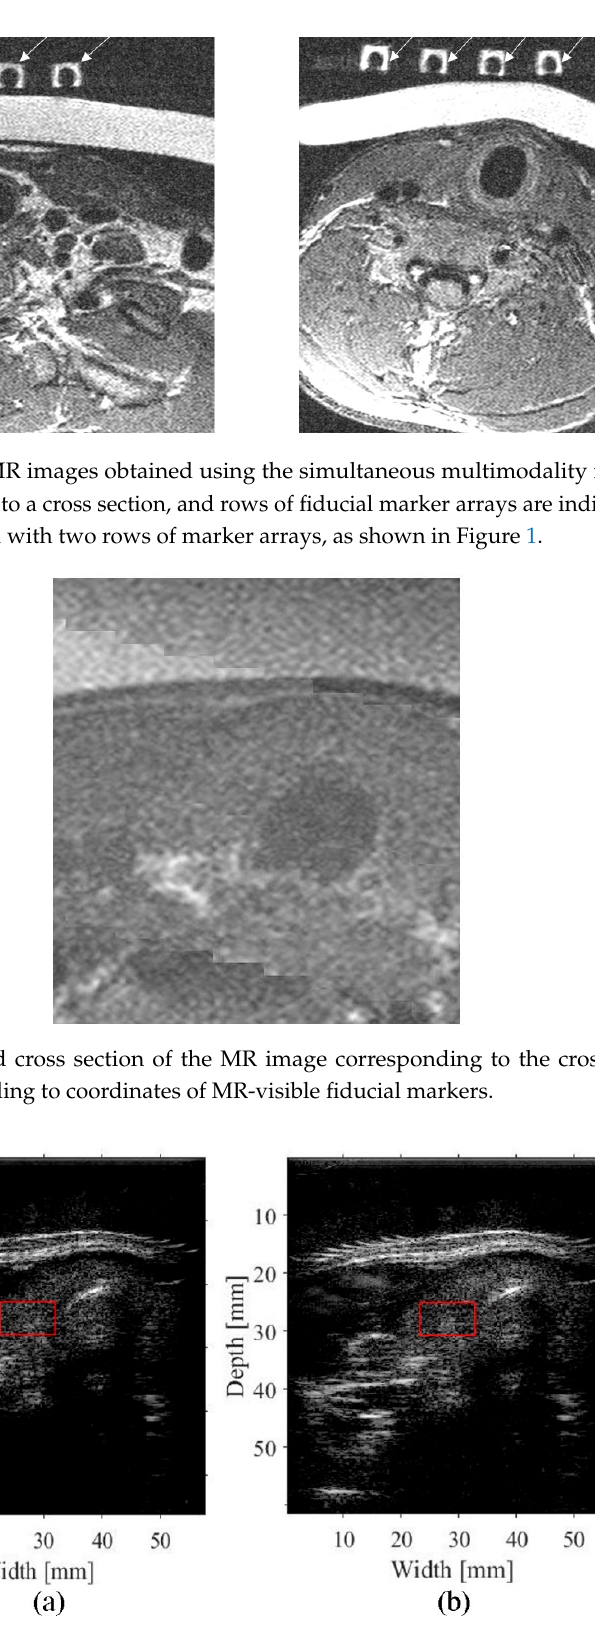
Figure 10. B-mode images of the neck obtained using the proposed method of compensation ( a ) and a conventional approach ( b ). A red square indicates a ROI in part of the thyroid for the autocorrelation function in each B-mode image.